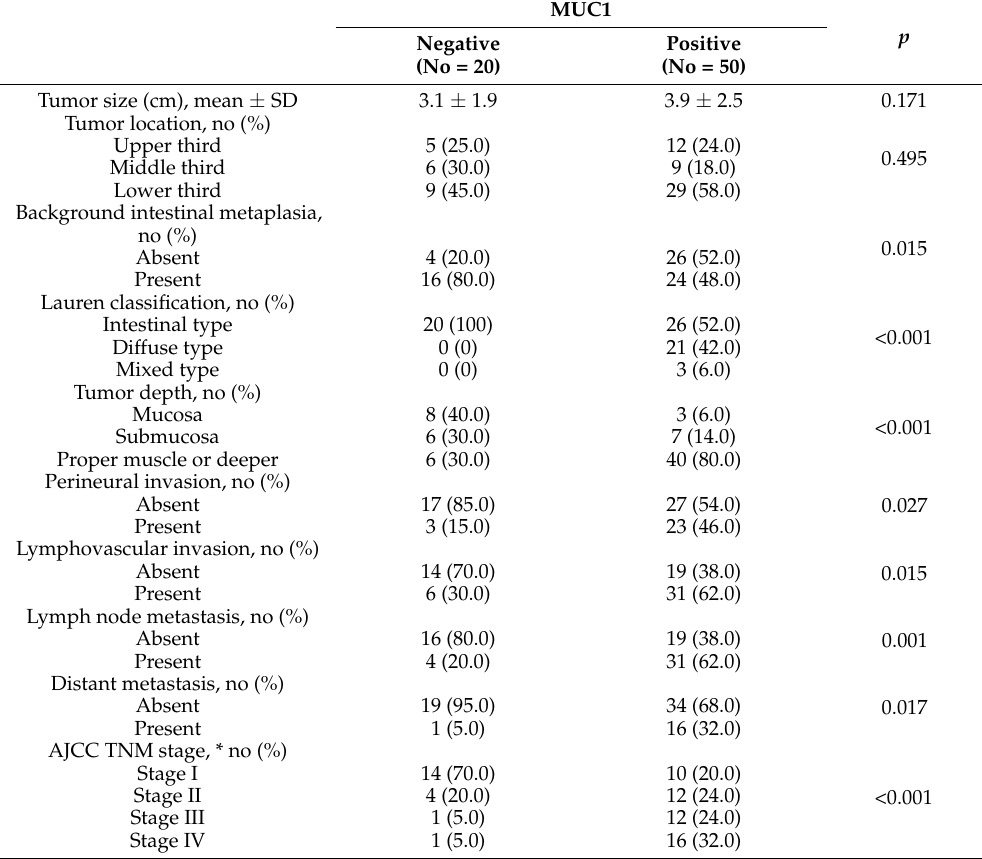
Abbreviations: MUC, mucin; SD, standard deviation; AJCC, American Joint Committee on Cancer. * Final pathological cancer stages were classified according to the 7th edition of AJCC TNM staging